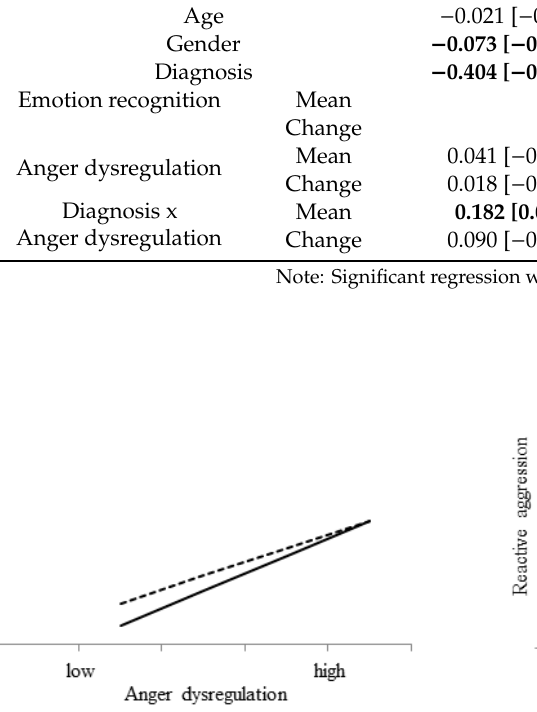
Table 3. Regression weights with 95%CI for best-fitting models with emotion recognition and anger dysregulation predicting reactive aggression and Oppositional Deviant Disorder (ODD) symptoms. Reactive Aggression ODD Symptoms